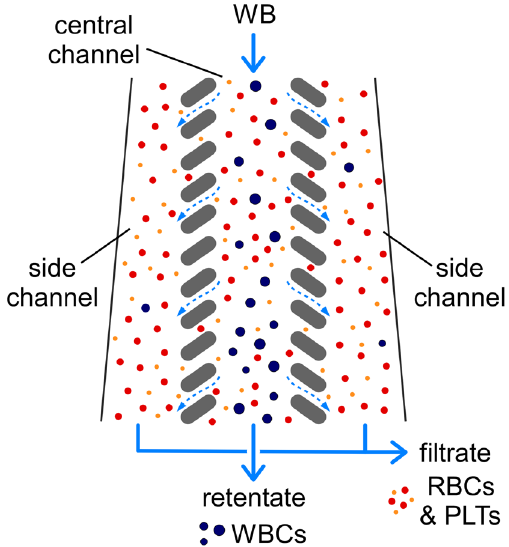
Figure 1. The separation of WBCs from RBCs and PLTs via controlled incremental filtration (CIF). Most WBCs are too large to be pulled by the filtrate into the side channels, and therefore they are retained and concentrated in the central channel. RBCs and PLTs are smaller than the critical diameter of the device, and therefore they are distributed between the filtrate and the retentate according to the device flow